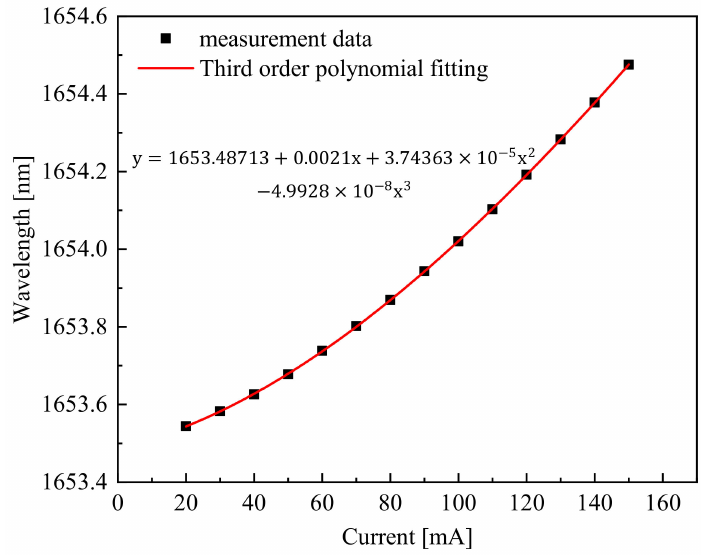
Figure 2. DFB laser wavelength as a function of driving current at 20 ◦